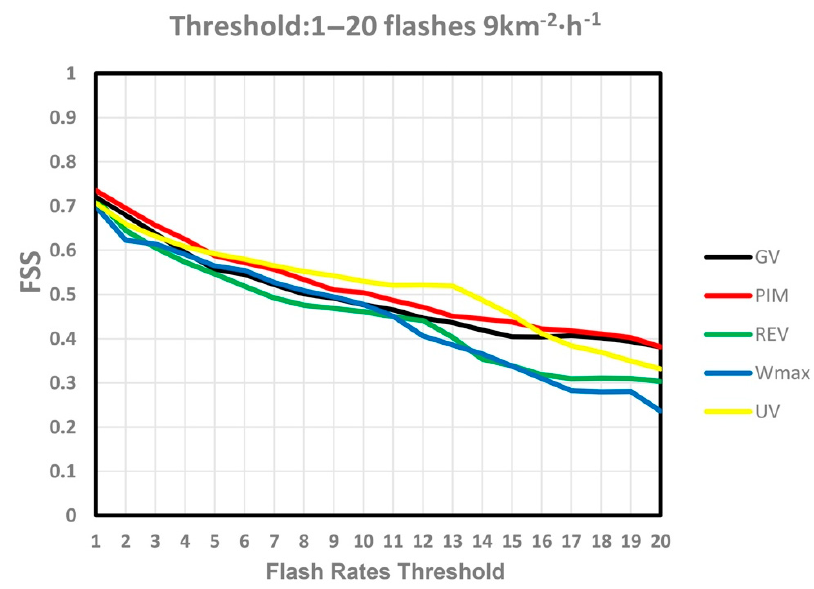
Figure 6. FSS statistics of hourly lightning flash rates simulated by different lightning diagnostic schemes with different proxies for the thresholds from 1 flash 9 km − 2 h − 1 to 20 flashes 9 km − 2 h − 1 .